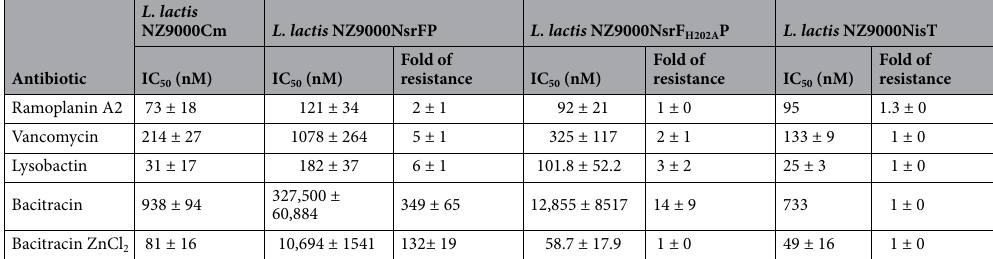
Table 1. Measured IC 50 values and calculated fold of resistance for the antibiotics ramoplanin A2, vancomycin, lysobactin and bacitracin and for the strains NZ9000Cm, NZ9000 Sa NsrF H202A P and NZ9000 Sa NsrFP. The control strain NZ9000NisT was only treated with bacitracin or (Zn)-bacitracin. Each measurement was performed at least by 3 biological replicated with 3 technical replicates each.